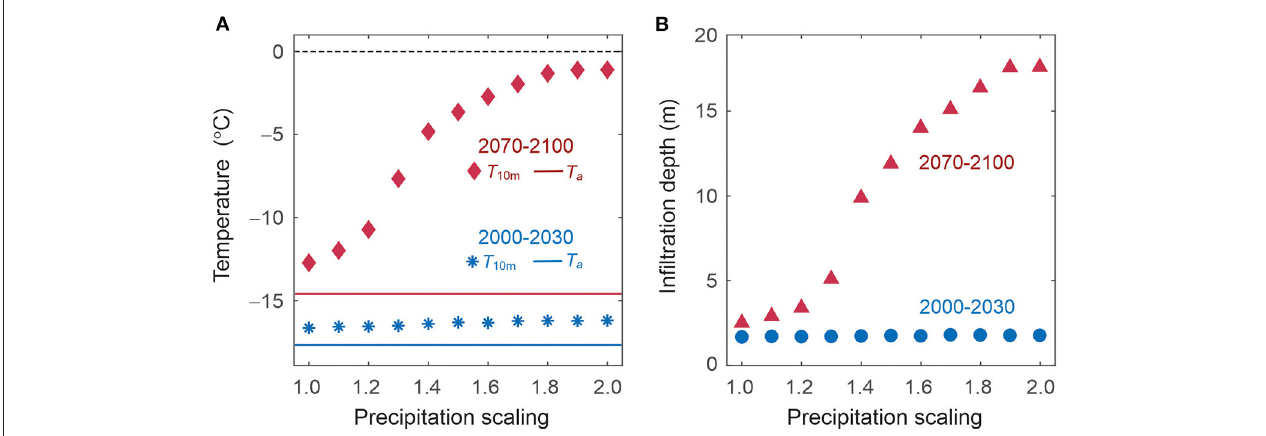
FIGURE 6 | Effects of snow accumulation rate on modelled 21st-century (A) 10-m firn temperature and (B) meltwater infiltration depth at DYE-2, Greenland. Blue symbols are average values for the period 2000–2030 and red symbols are for 2070–2100. Lines in (A) indicate the mean annual air temperature for each period. Temperatures and infiltration depths are plotted for precipitation rates up to twice the present-day value at DYE-2, giving winter mass balances b w ǫ [1, 2].